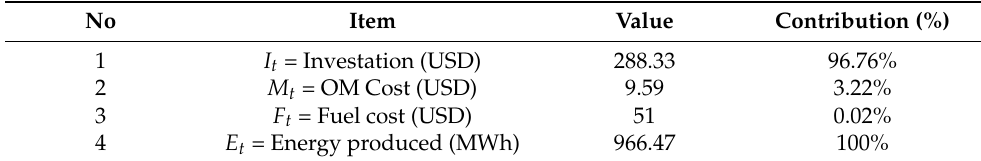
Table 3. LCOE and EPC calculation variables.